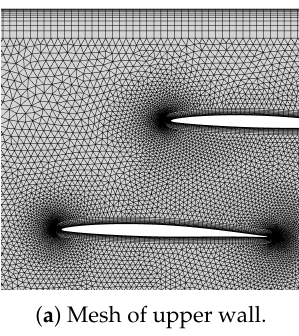
Figure 7. Linear cascade